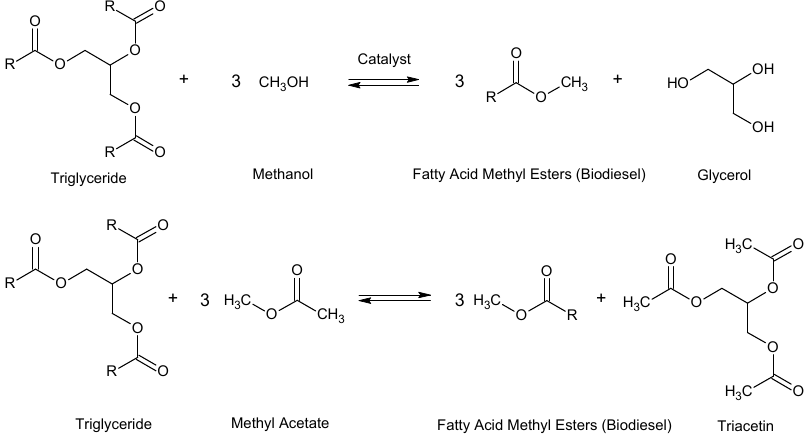
Figure 1. Scheme of transesterification ( up ) and interesterification ( down ) reaction. The effectiveness of pervaporation for methyl acetate-water mixtures was checked for Borisov et al. [21]. Experiments were performed varying the concentration of methyl acetate (0–1.5 wt%) and the temperature (30, 40, and 50 ◦ C). The intrinsic enrichment factor changes